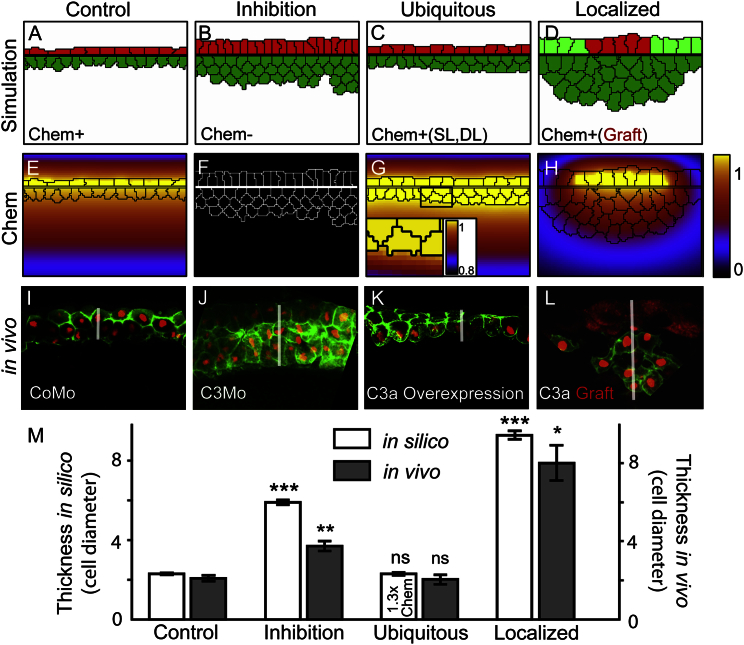
Localization of Chemoattractant Source Determines Radial Intercalation(A–H) Simulated cell configurations and corresponding chemoattractant levels at the end of epiboly with different localizations of chemoattractant production: only in the SL (Control, A, E), nowhere (Inhibition, B, F), in every cell (Ubiquitous, C, G), and in a restricted region of the SL (Localized, D, H, producing region shown in red).(I–L) Experimental validation of the predicted behavior showing sections of the blastocoel roof of stage 11 embryos. Red, nucleus; green, membrane; graft in (L) marked with cytosolic RLDx. White bar indicates tissue thickness.(M) Quantification of tissue thickness, measured in units of cell diameter after normal epiboly (20 μm), for the four settings in silico and in vivo. Error, SD. Significances compared with relevant control: ∗p < 0.05, ∗∗p < 0.01, ∗∗∗p < 0.001; ns, p > 0.05. 1.3× Chem denotes 1.3-fold overexpression in both DCs and SCs.